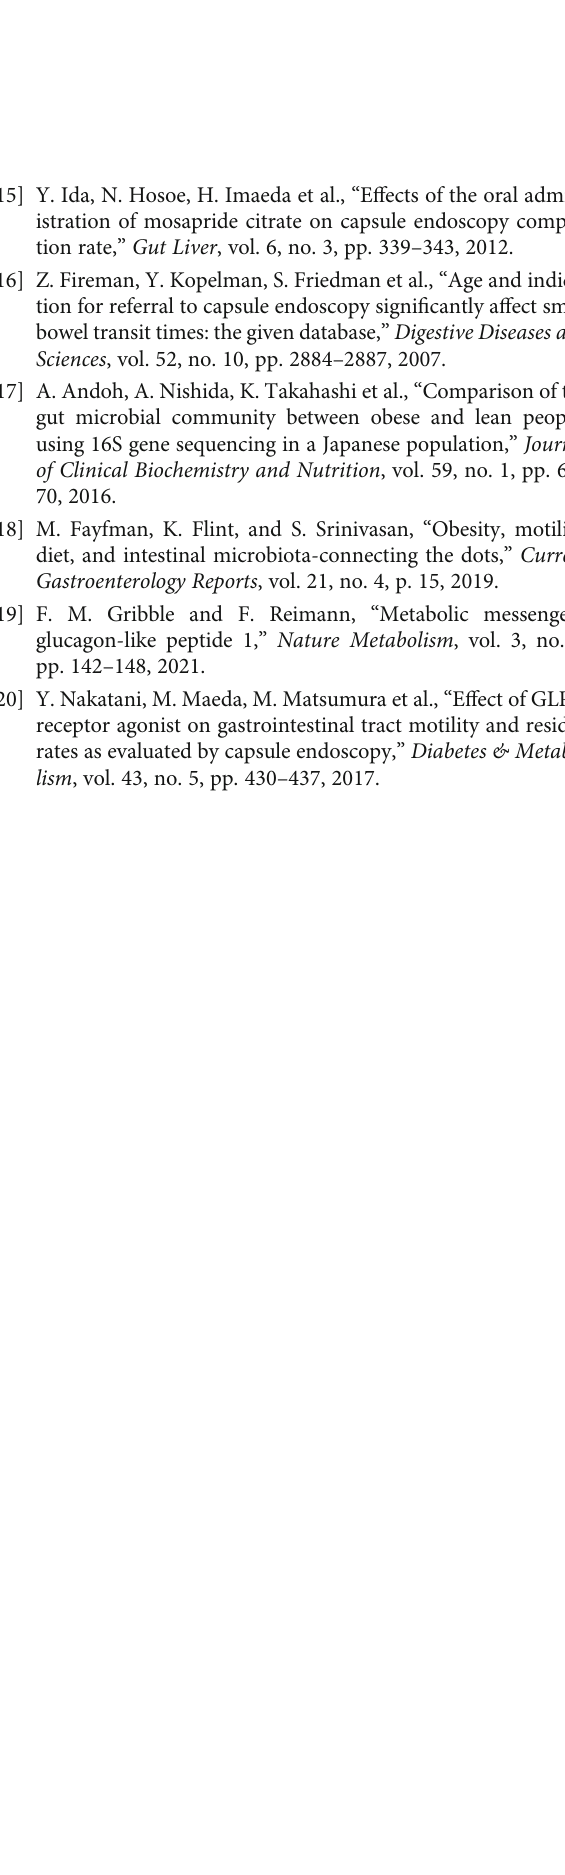
Supplementary 2 . Supplementary Figure 1: the BMI value with the largest area under the curve